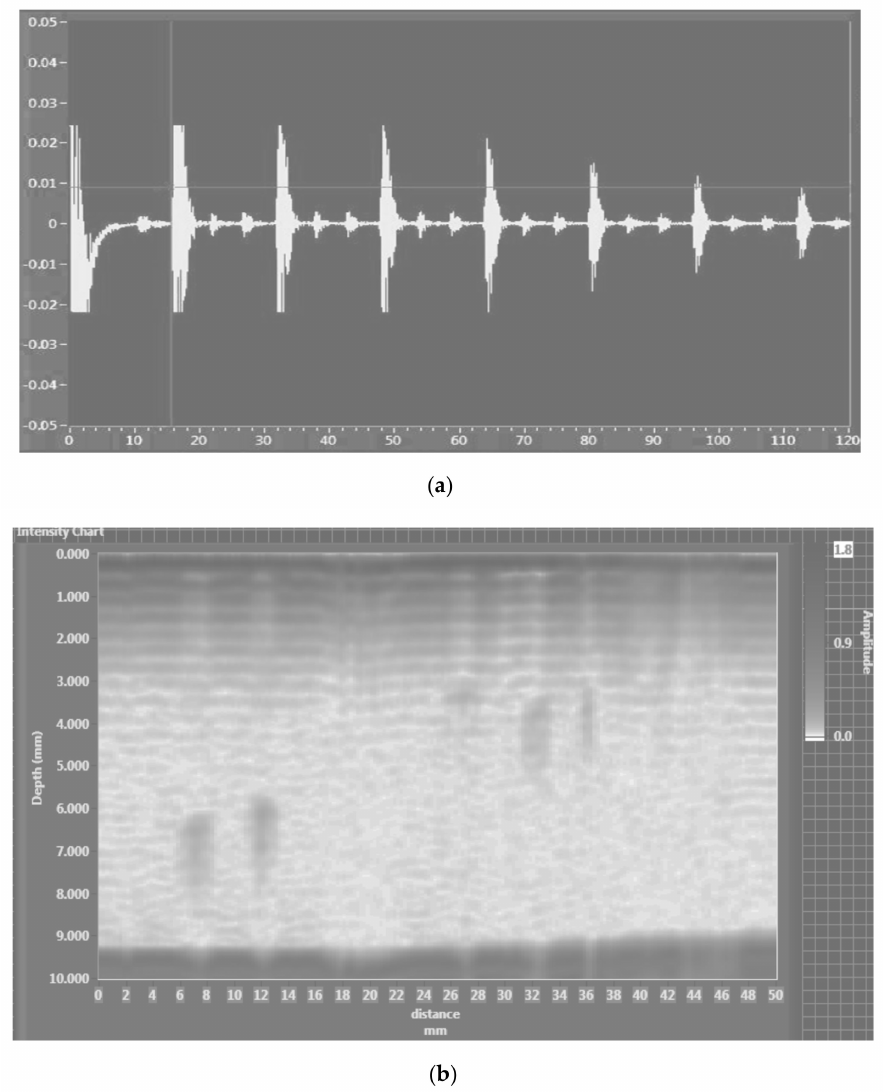
Figure 24. Ultrasonic measurement technique ( a ); data acquisition amplitude modulated scan; ( b ) ultrasonic imaging for the analysis of rail fracturing inside the subway